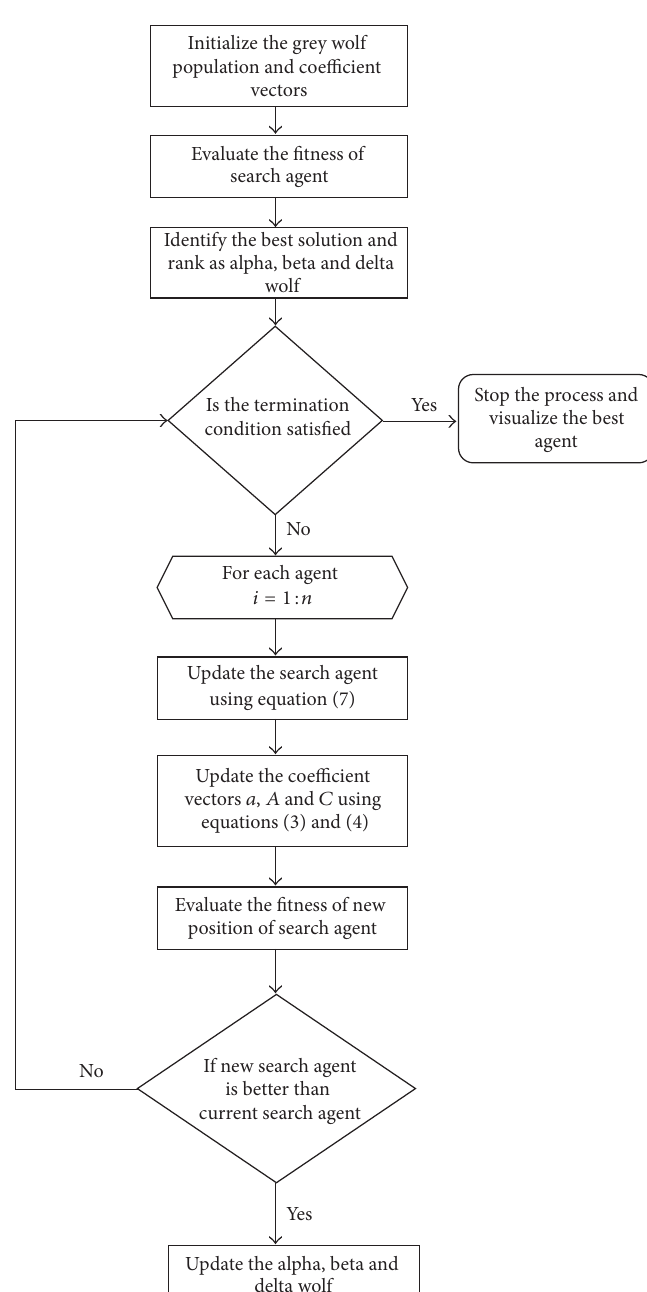
Figure 1: Flowchart of grey wolf optimization (GWO)